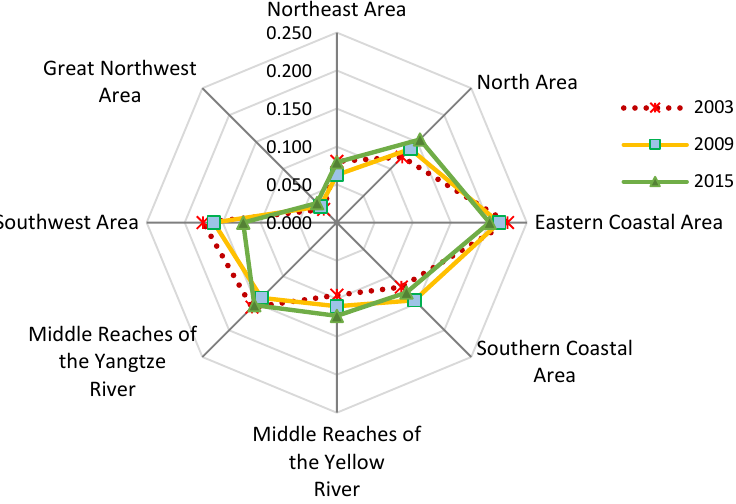
Figure 8. National shares of industrial wastewater emission in the eight areas, 2003–2015. Data resources: Annual Statistic Report on Environment in China [16].